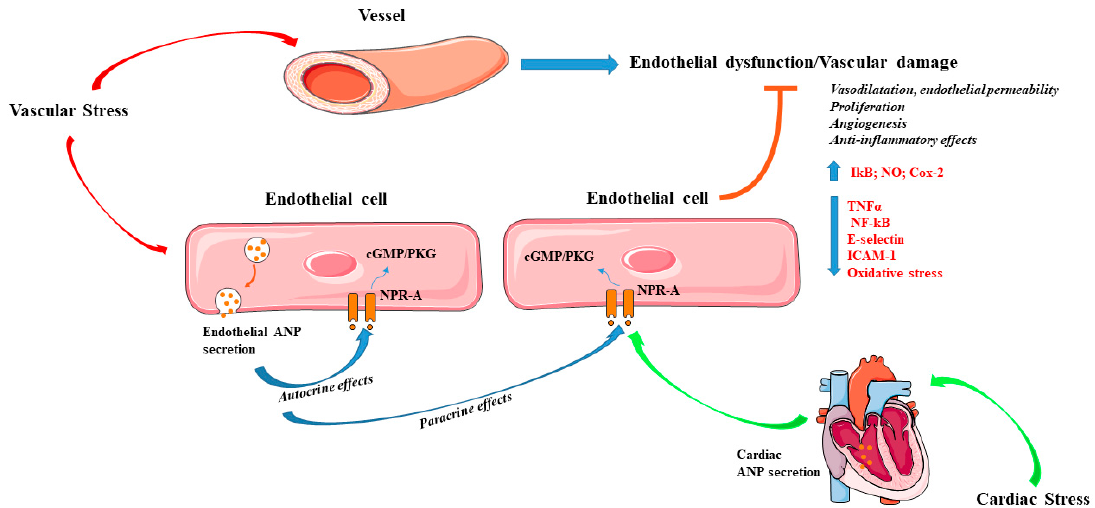
Figure 2. E ff ects of atrial natriuretic peptide (ANP) in the vascular system. The contribution of either endothelial and cardiac-derived ANP in response to stress prevents endothelial dysfunction and vascular damage. ANP increases vasodilatation and endothelial permeability, stimulates angiogenesis, proliferation, nitric oxide production, and exerts anti-inflammatory e ff ects. Arrow-headed lines indicate activation whereas bar-headed lines indicate inhibition. Legend: cyclic guanosine monophosphate (cGMP); ciclooxygenases-2 (Cox-2); intercellular Adhesion Molecule 1 (ICAM-1); natriuretic peptide receptor type A (NPR-A); nitric oxide (NO); nuclear factor kappa-light-chain-enhancer of activated B cells (NFkB); protein kinases G (PKG); tumour necrosis factor alpha (TNF α ). See text for further details. The figure was made using tools provided by Servier Medical Arts, amongst others.